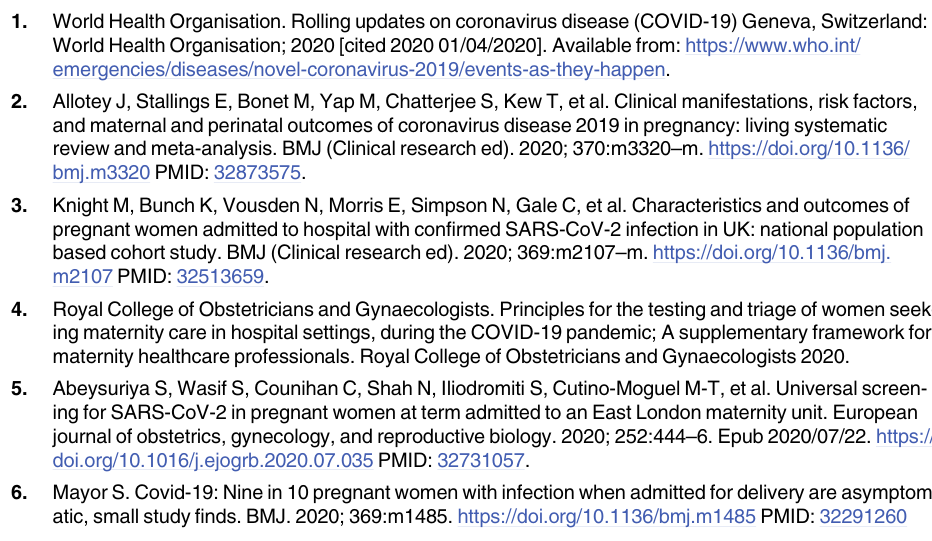
S8 Table. Hospital, pregnancy and infant outcomes amongst women with confirmed